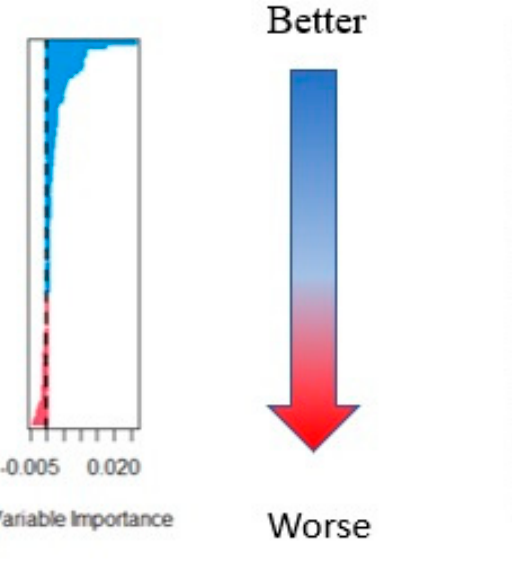
Figure 4. Partial variable dependence plots of the 3 selected radiomics.